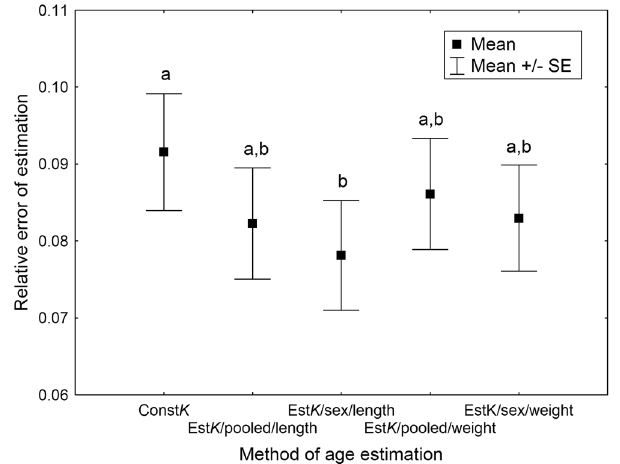
Figure 3. Relative error of C. maxillosus physiological age ( K ) at emergence estimation using different methods. Const K – the use of constant K (from the general thermal summation model, 417.33 ADD over 11.58 °C after Frątczak-Łagiewska & Matuszewski 24 ); Est K/ pooled/length – estimation of K using the model for the pooled sample and beetle length at emergence as the predictor variable; Est K/ sex/length – estimation of K using models for females and males and beetle length at emergence as the predictor variable; Est K/ pooled/weight – estimation of K using the model for the pooled sample and beetle weight at emergence as the predictor variable; Est K/ sex/ weight – estimation of K using models for females and males and beetle weight at emergence as the predictor variable. Different letters denote significant differences in pairwise comparisons (absolute differences between mean ranks were significant at 5% level of significance, if they were larger than 0.477).